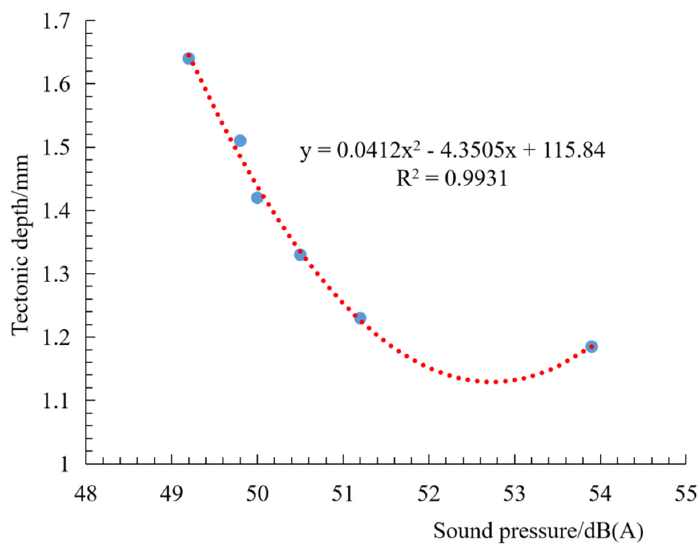
Figure 13. The relationship between structural depth and noise.